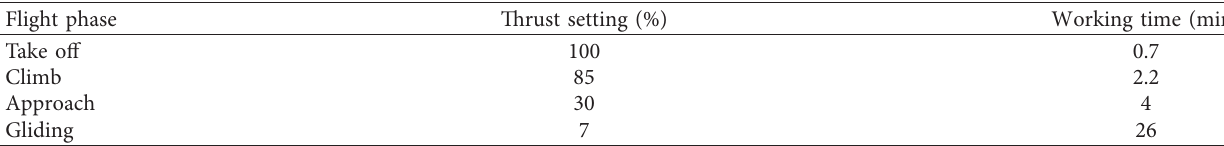
Table 2: Engine thrust setting and working time under different working conditions of standard LTO cycle specified by ICAO [15].